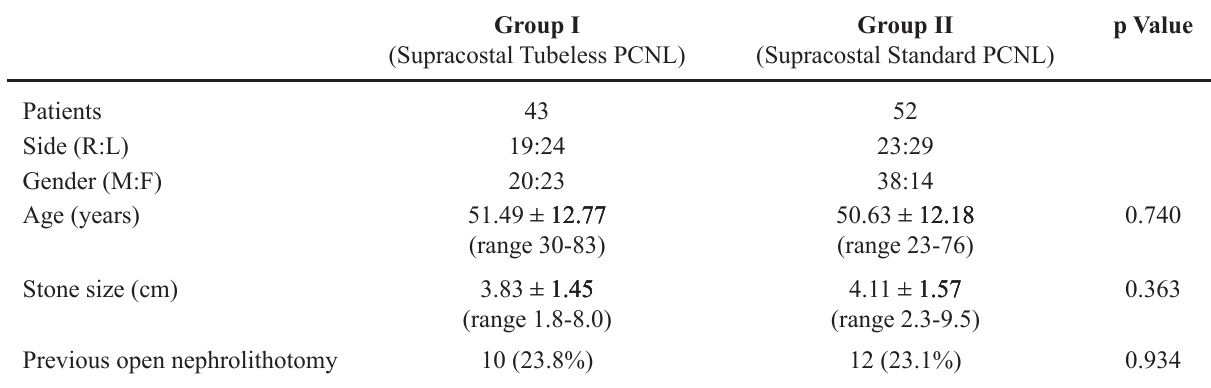
Table 1 – Profiles of